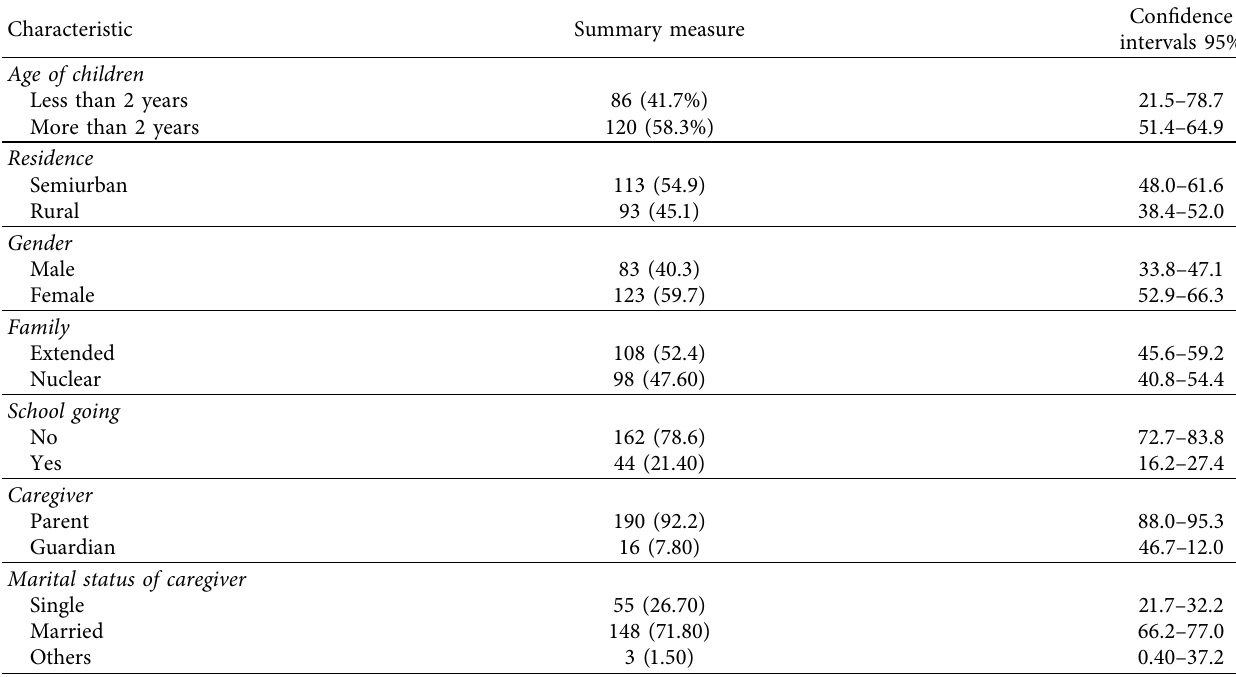
Table 1: Sociodemographic and clinical factors of children aged 1–5 years attending the selected health units in Bushenyi district.